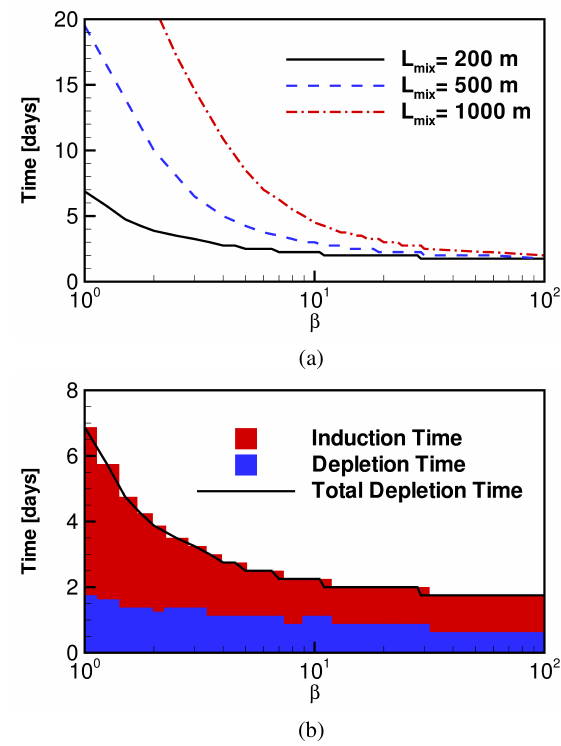
Fig. 8. Impact of the reactive surface ratio on the (a) total ozone de- pletion time for three different boundary layer heights, (b) induction and depletion times for a 200m boundary layer